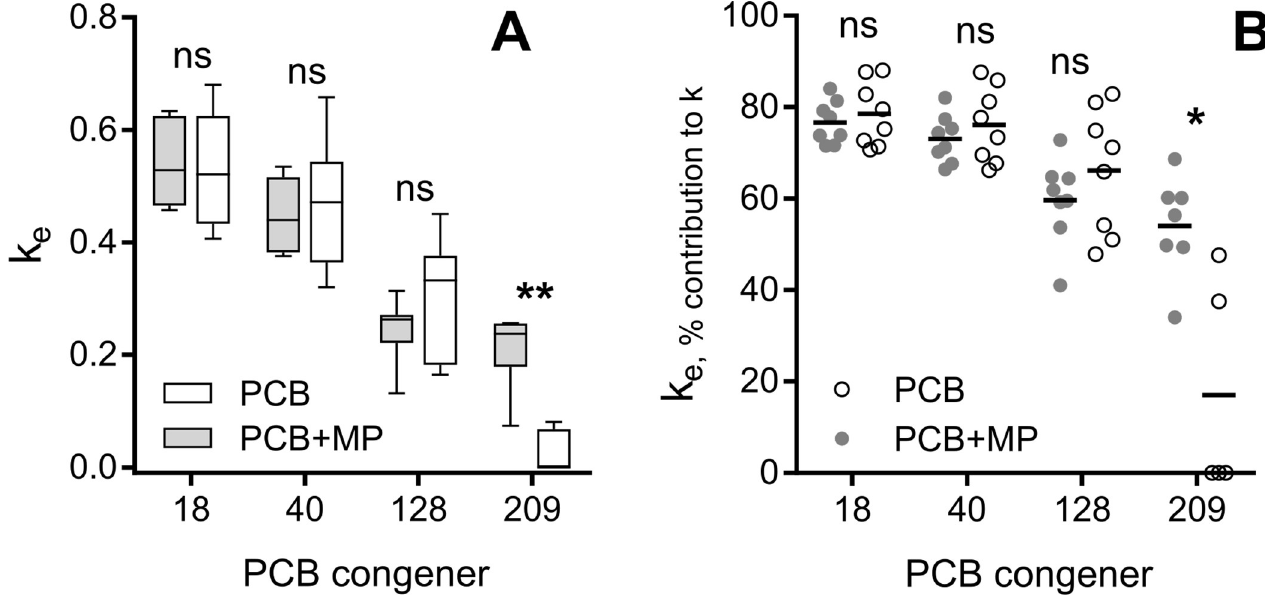
Fig 2. Elimination rate and the importance of growth dilution. Elimination rate constant (k e ) for all PCB congeners (A) and contribution of k e to the overall elimination rate (k) that accounts for growth dilution (B) during the depuration phase, ns: p > 0.05, � : p < 0.05, �� : p < 0.01.